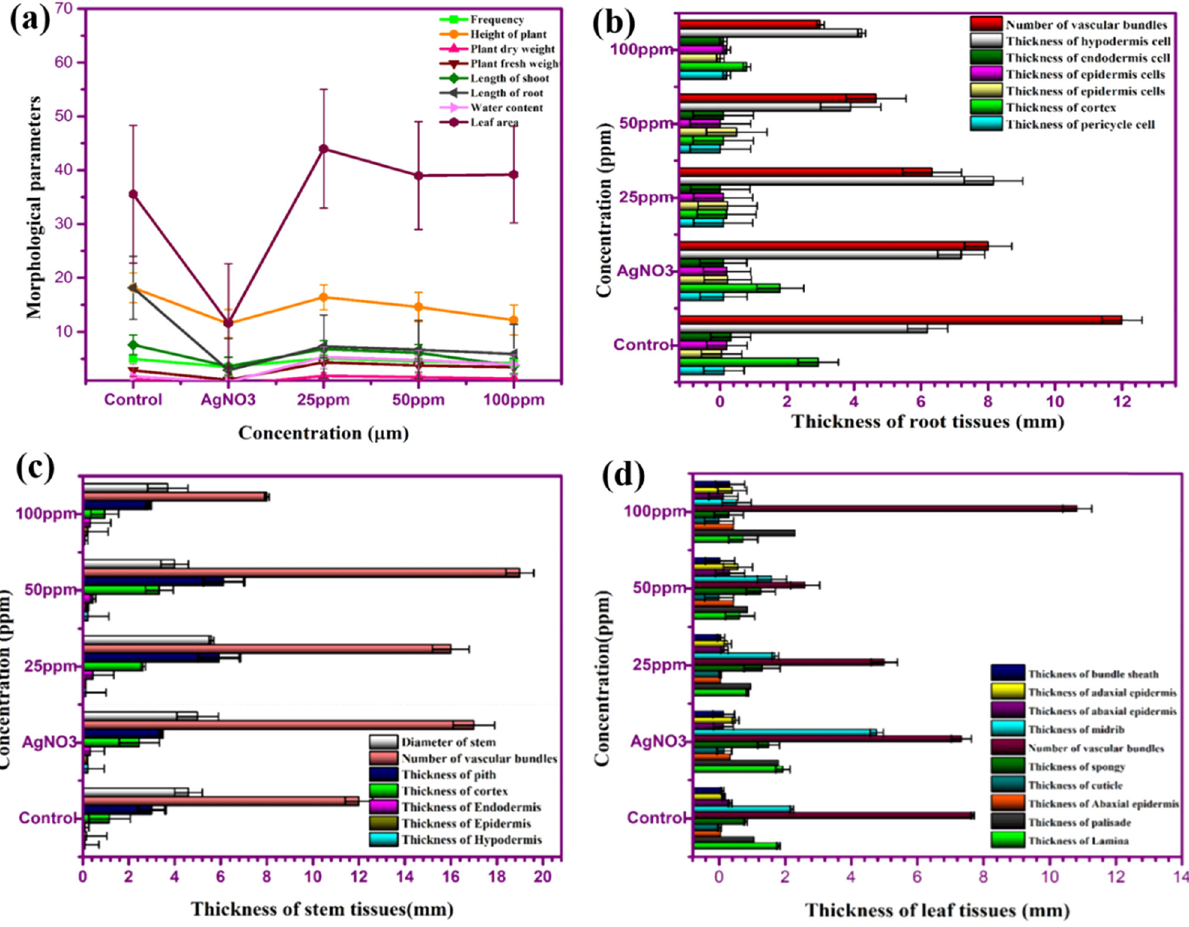
Figure 2: Foliar application of silver nanoparticles with 25, 50, and 100 ppm on L. sativa morpho - anatomical changes ( a ) , thickness of root tissue ( b ) , thickness of stem tissue ( c ) , and thickness of leaf tissue ( d )